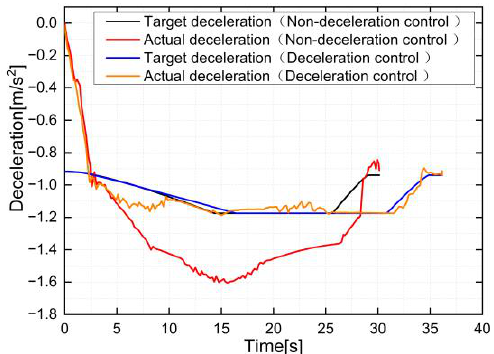
Figure 14. Test result with a combination of uncertain parameters.